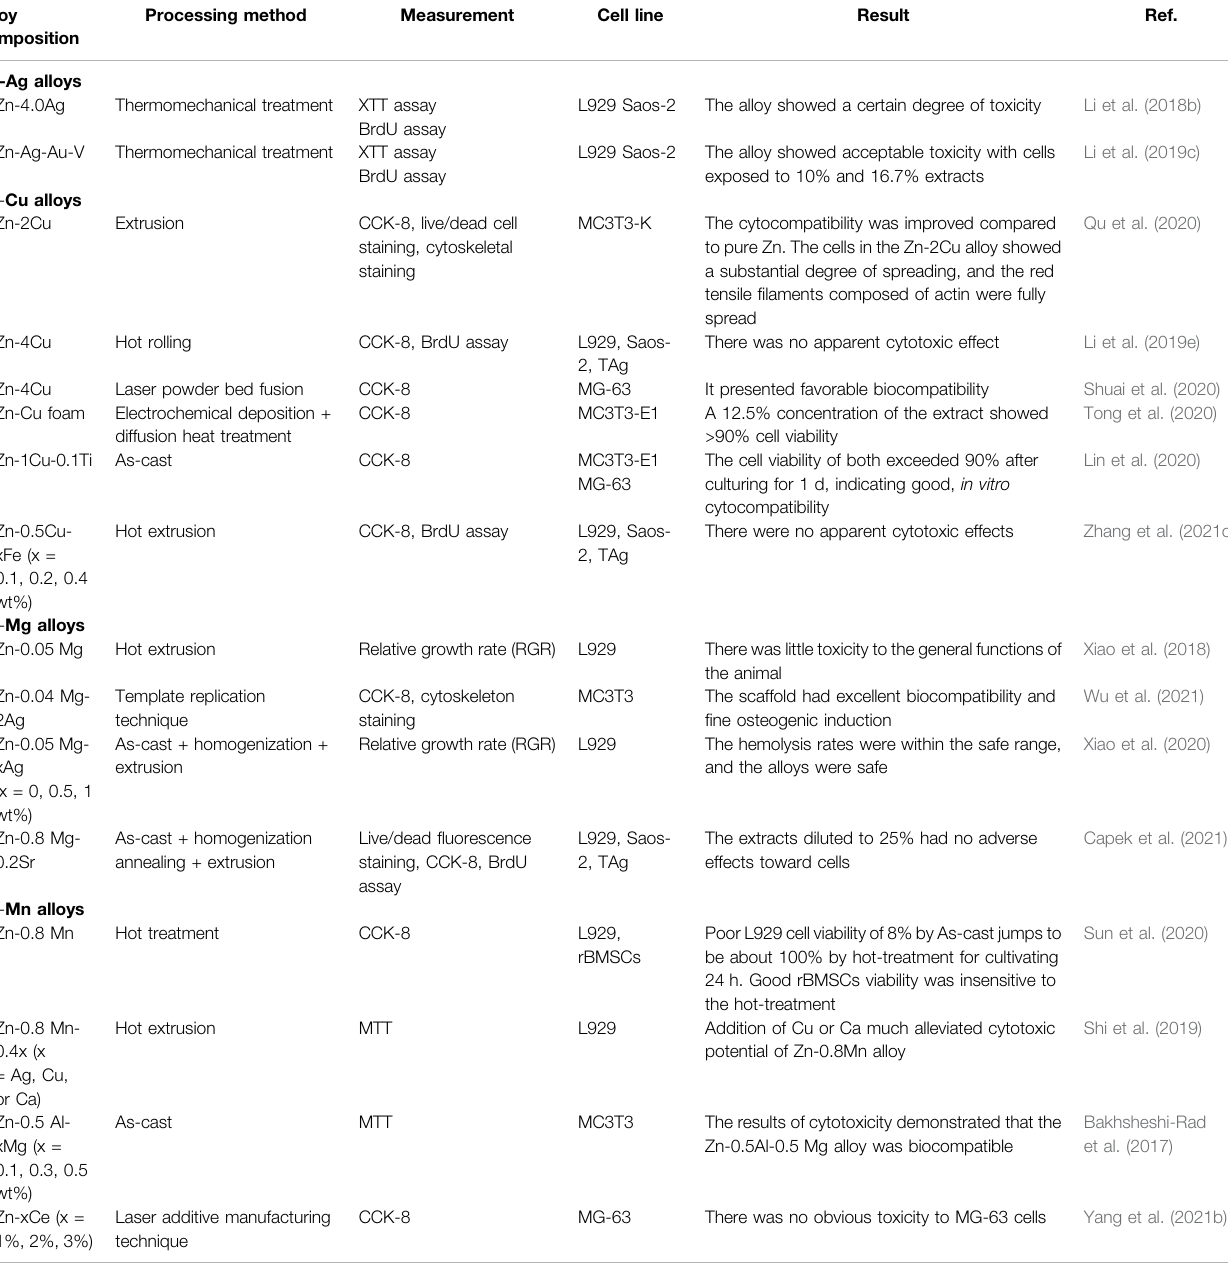
TABLE 12 | In vitro biocompatibility of Zn-based alloys with antibacterial properties as orthopedic